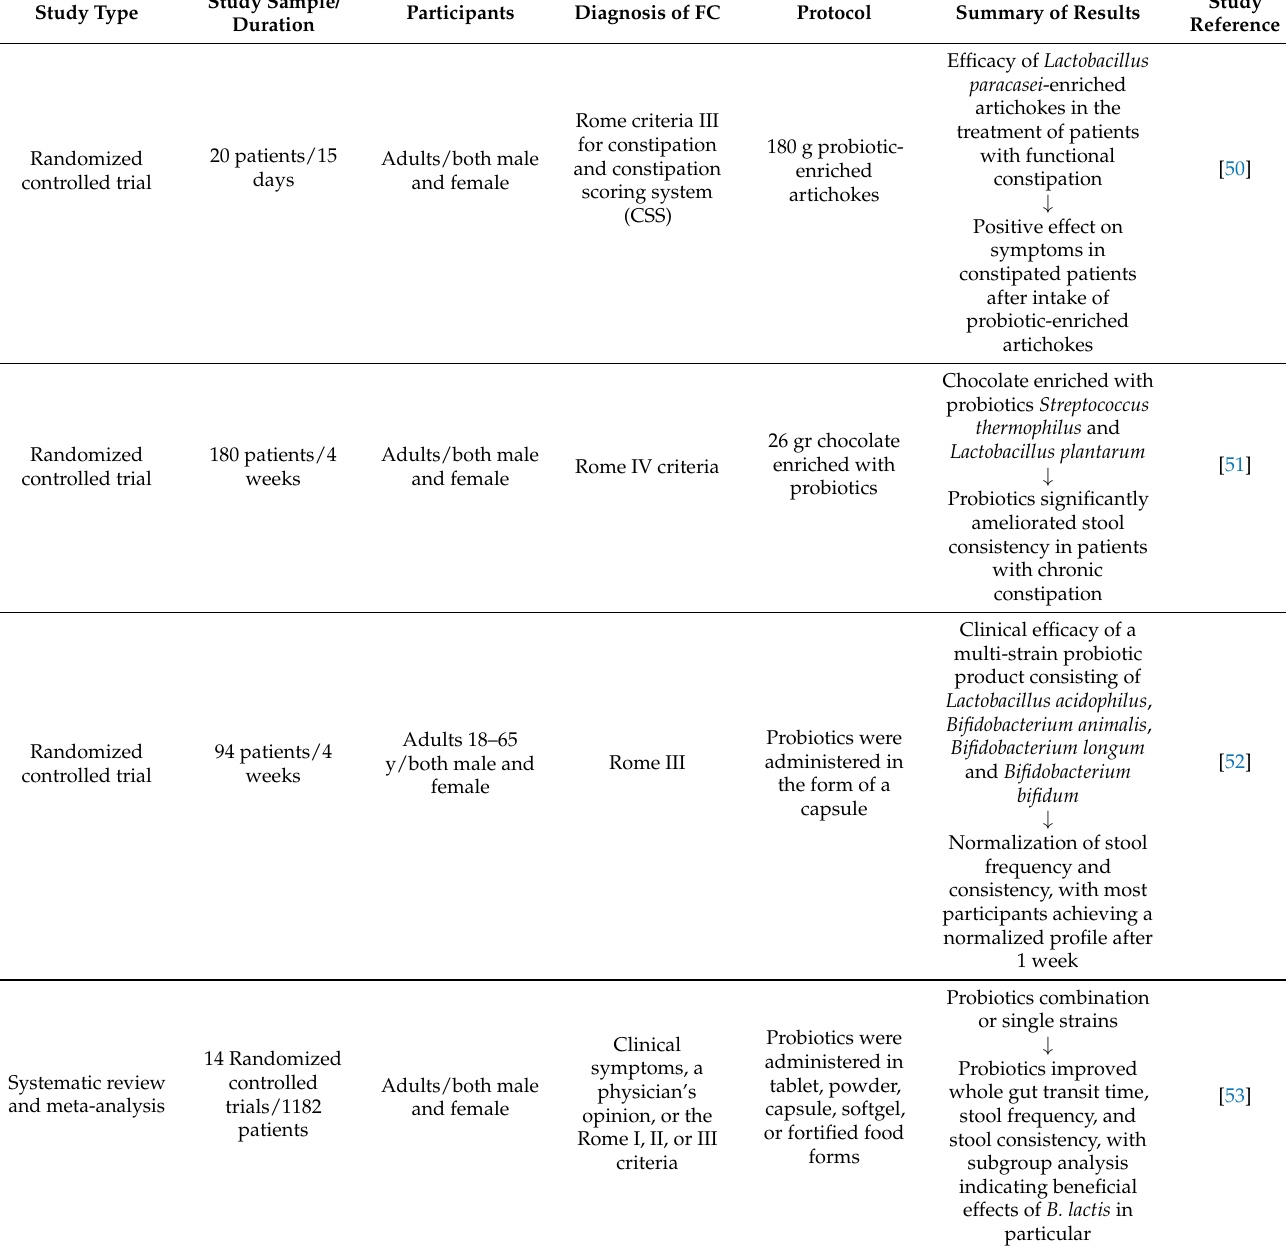
Table 3. Studies that summarize the efficacy of probiotics in treating functional